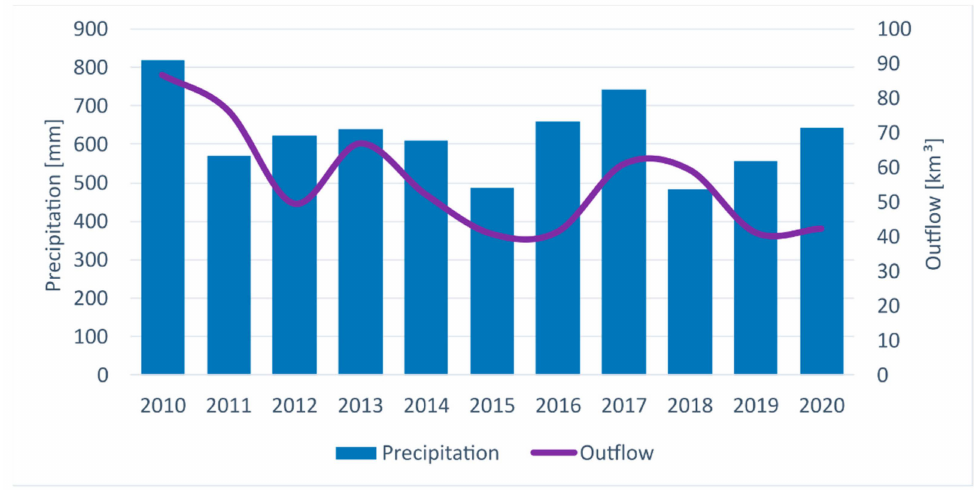
Figure 2. Precipitation and outflow from the area of Poland in the multi-year period 2010–2020 [23]. The outflow does not include the transboundary catchments and rivers of the